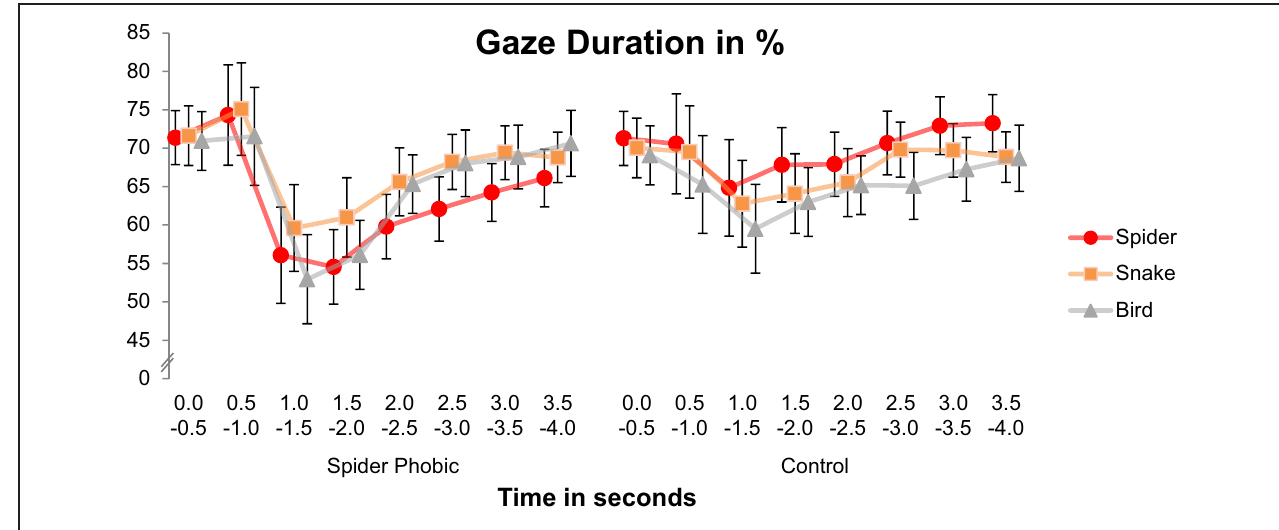
FIGURE 2 | Gaze duration on the pictures presented as a function of animal, time, and group. Error bars depict standard errors.